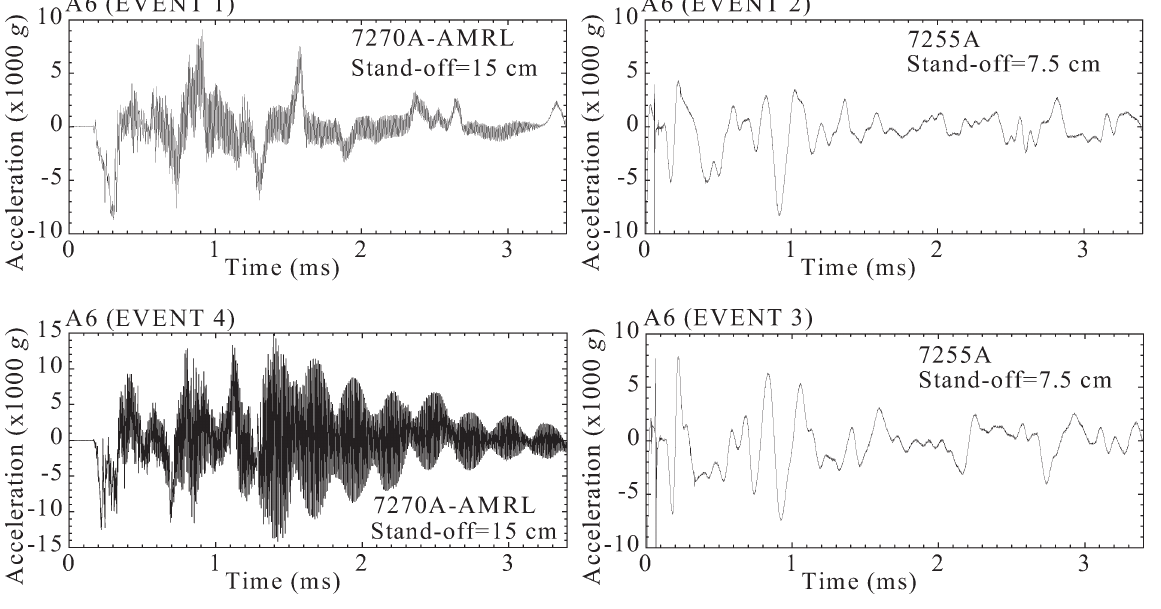
Fig. 9. Acceleration results for location A6 at 7.5 and 15 cm stand-off distances, from 10 g of